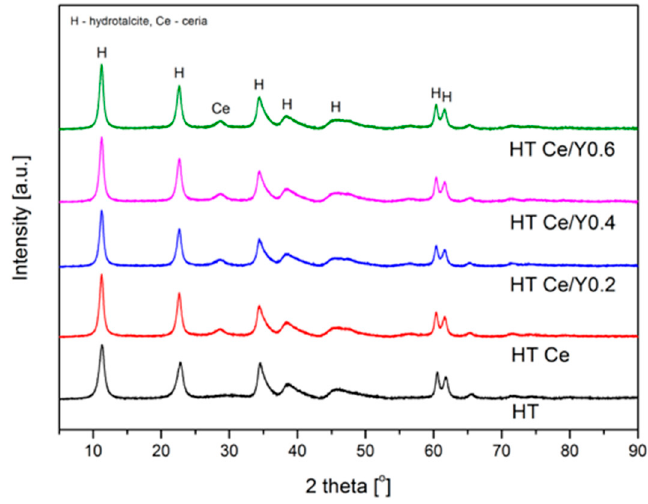
Figure 1. XRD patterns of freshly synthesized double-layered hydroxides (HT) catalysts: HT, HT Ce, HT Ce/Y0.2, HT Ce/Y0.4, HT HT Ce/Y0.2, HT Ce/Y0.4, HT Ce/Y0.6.